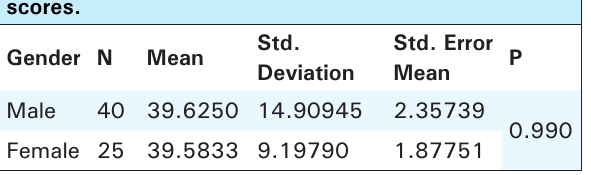
Table 2. Analysis of variance. df